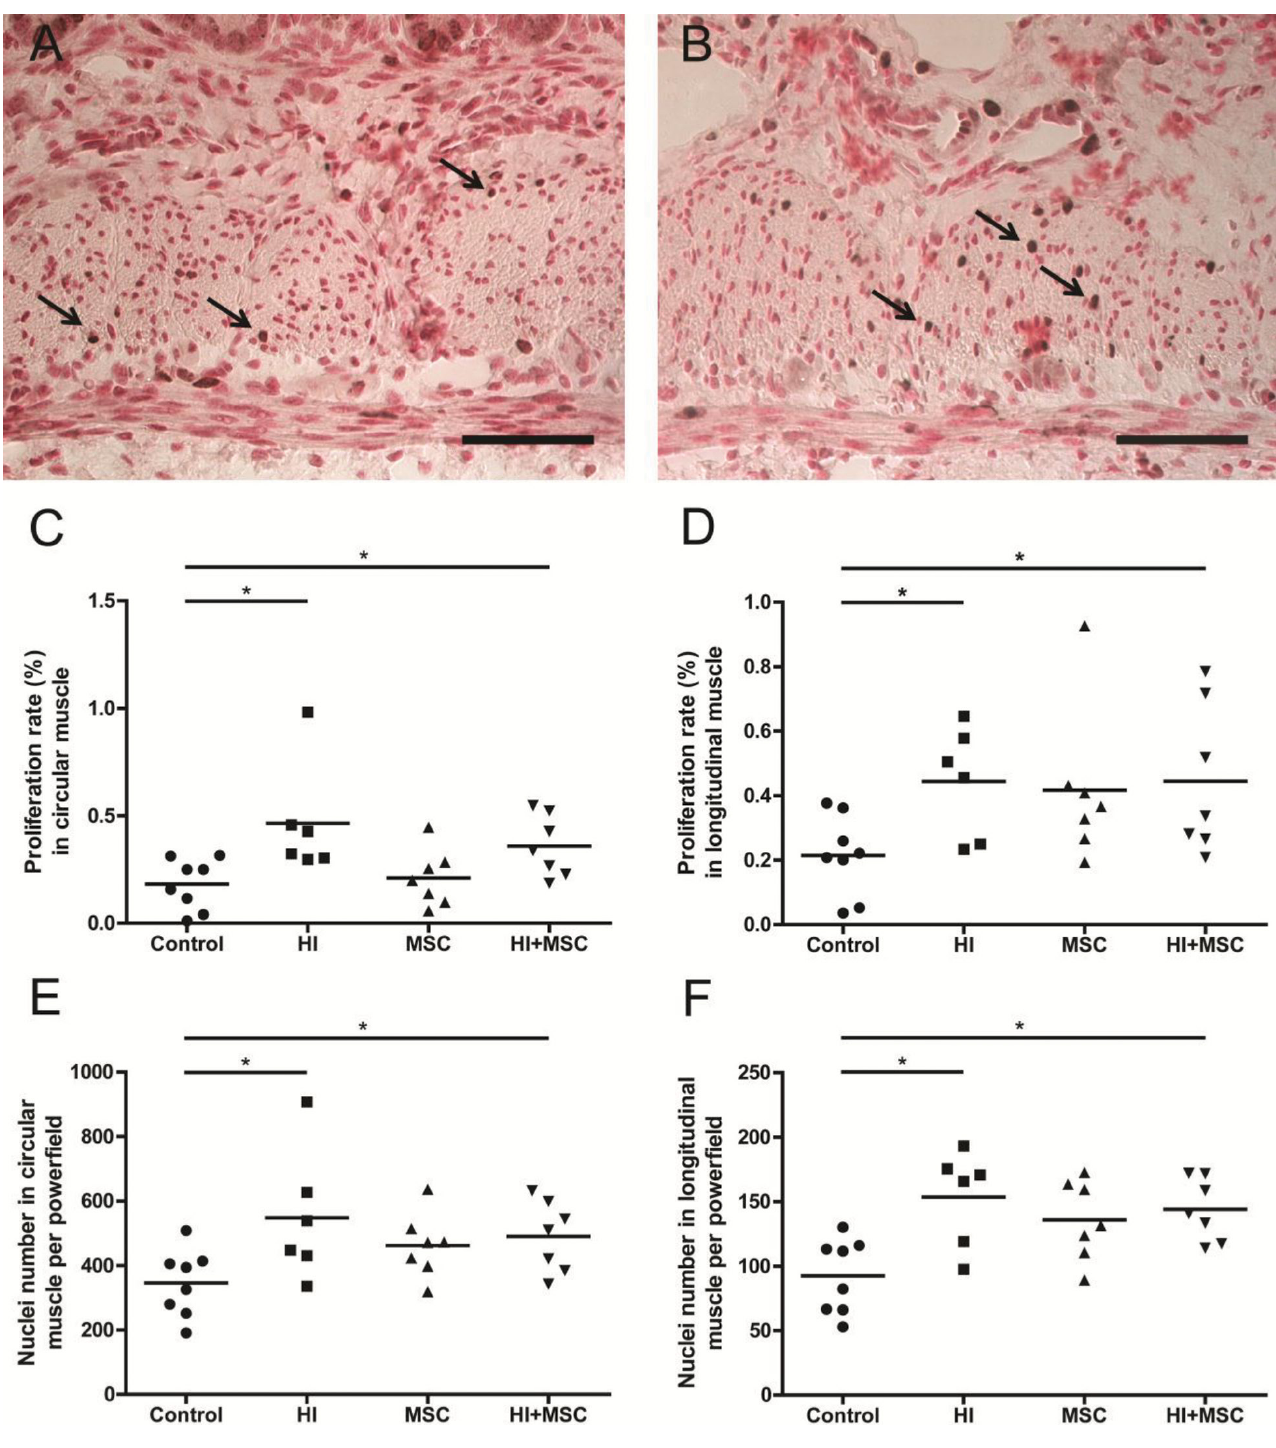
figure 6. Increased proliferation rate and number of nuclei in muscle layers 7 d after HI. Representative intestinal sections of (A) control and (B) HI animals were stained by immunohistochemistry for Ki67. For each experimental group, proliferation rate in (C) circular and (D) longitudinal and nuclei numbers in (E) circular and (F) longitudinal muscle layer were counted, and the mean cell counts per power field per animal are given. The proliferation rate (%) is expressed per 1000 μ m 2 . The arrows indicate Ki67 + cells within the muscle layers. The scale bar in panels A and B represents 50 μ m. * p <